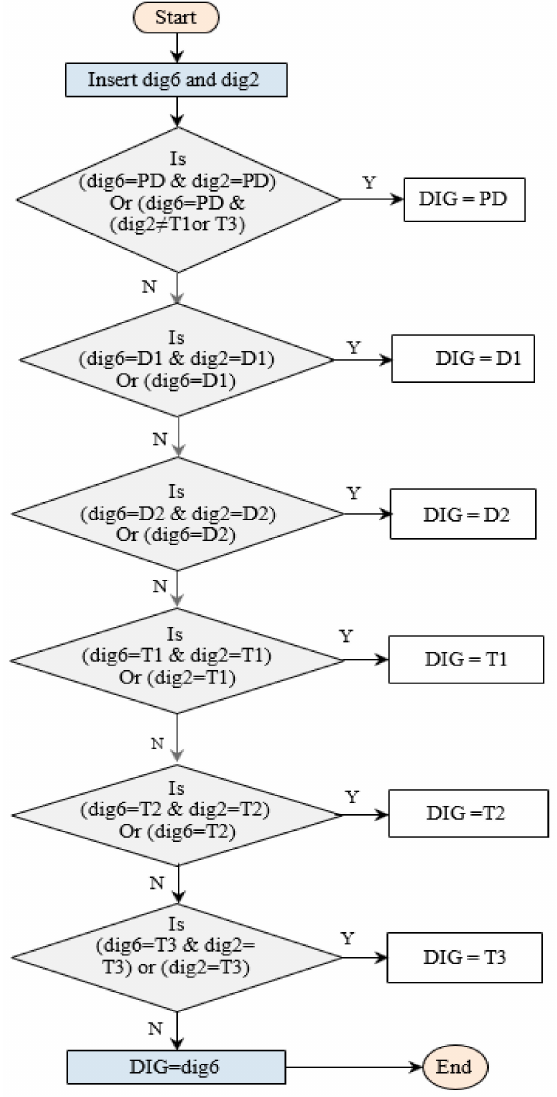
Figure 4. Flowchart procedure of technique no.